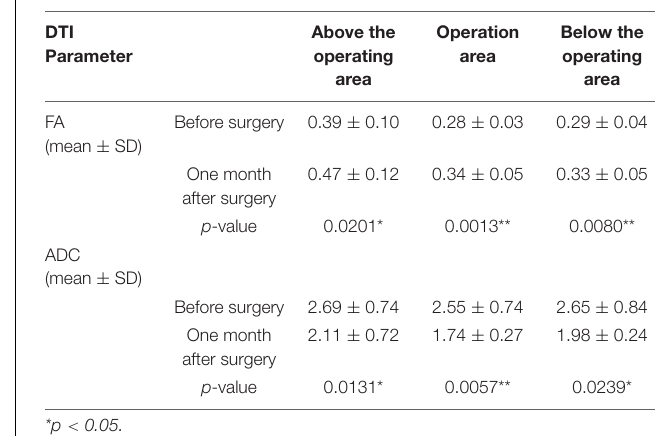
TABLE 6 | Statistical analysis of DTI data